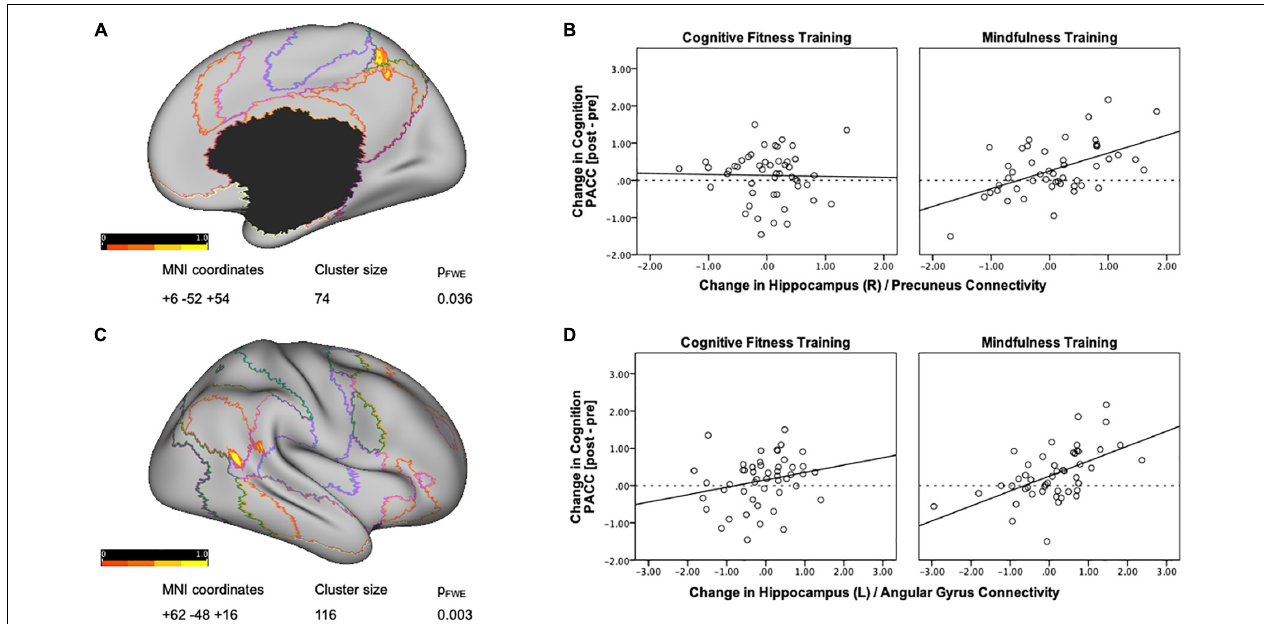
FIGURE 2 | Training-dependent changes in hippocampal connectivity strength that covary with changes in cognition. (A) A whole brain gPPI analysis of changes in functional connectivity (baseline vs. post-intervention) using change in PACC scores as regressor and right hippocampus as seed resulted in a significant cluster at the right precuneus for the mindfulness training group. Networks are based on the Yeo seven-network parcellation (Yeo et al., 2011) and are represented by the following colors: violet: visual, blue: somato-motor, green: dorsal attention, pink: ventral attention, cream: limbic, orange: fronto-parietal, and red: default network. (B) Mindfulness-training-dependent improvements in PACC cognitive composite scores correlated with increases in intrinsic connectivity between the right hippocampus and the right precuneus, while the Cognitive Fitness Training group showed no association. The connectivity estimates reflect the change in connectivity strength associated with training-dependent increases in cognition, and were plotted using SPSS v.24 (Chart Editor). The fitted regression line reflects the best estimate of the connectivity between the hippocampus and the precuneus in B . (C) A whole brain gPPI analysis of the changes in functional connectivity (baseline vs. post-intervention) using change in PACC scores as regressor and left hippocampus as seed resulted in a significant cluster at the right angular gyrus for the mindfulness training group. Networks are based on the Yeo seven-network parcellation (Yeo et al., 2011) and are represented by the following colors: violet: visual, blue: somato-motor, green: dorsal attention, pink: ventral attention, cream: limbic, orange: fronto-parietal, and red: default network. (D) Mindfulness-training-dependent improvements in cognitive composite scores correlated with increases in intrinsic connectivity between the left hippocampus and the right angular gyrus, while the Cognitive Fitness Training group showed no association. The connectivity estimates reflect the change in connectivity strength associated with training-dependent increases in cognition, and were plotted using SPSS v.24 (Chart Editor). The fitted regression line reflects the best estimate of the connectivity between the left hippocampus and the right angular gyrus in C